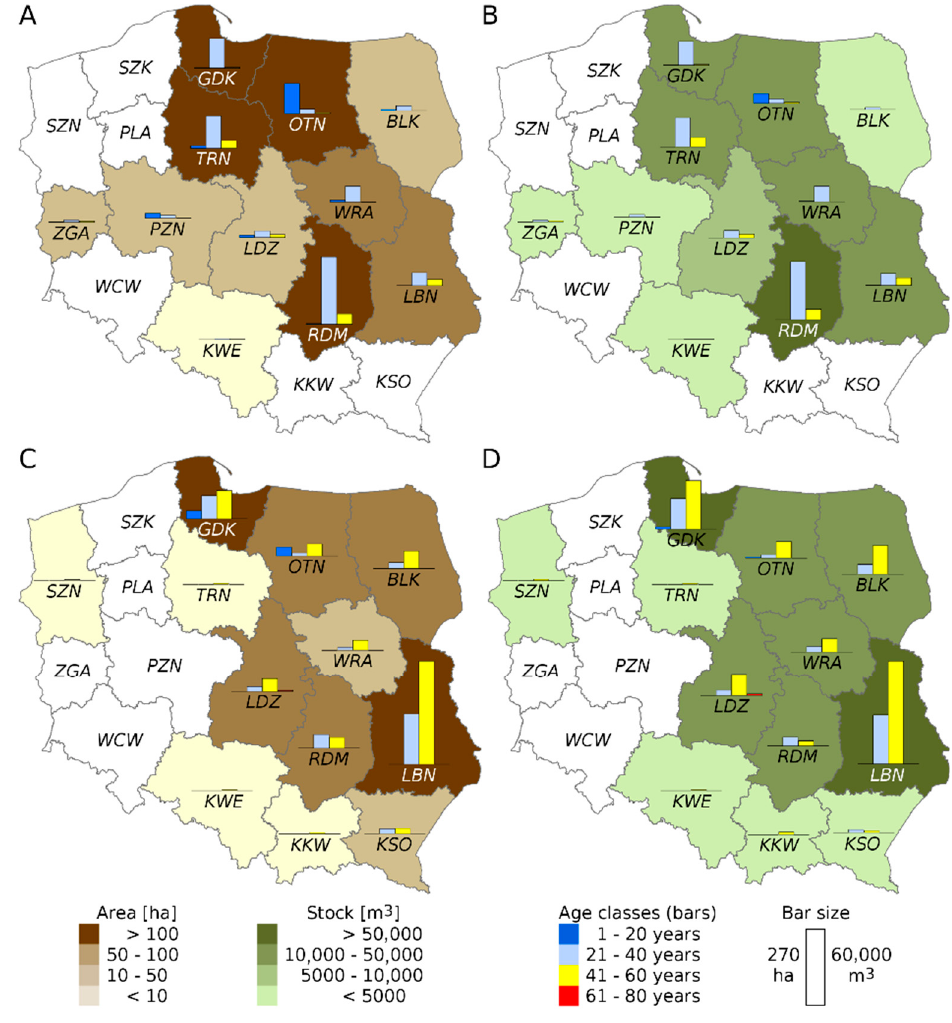
Figure 1. Arrangement of fast-growing tree plantations: ( A , B) larch and ( C , D ) poplar in the regional LP Directorates. The carto diagram of the surface and stock (thickness) broken down into age classes (bars) and the cartogram of the total surface (bronze shades, A , C ) and thicknesses (shades of green, B , D ). In the RDLP without the colours and bars, there is a lack of fast-growing tree plantations. The sizes of the bars are linear. The symbols of the regional names of the LPs are explained in Abbreviations. In addition to the legend: On the left, cartographic explanations (colours RDLP: shades of brown-surface and green-stock). On the right-hand side, explanations for the carto diagrams (the colours of the bars and their sizes). Abbreviations: RDLP-Regional Directorates of the State Forests; BLK-RDLP in Białystok; GDK-RDLP in Gda´nsk; KKW-RDLP in Krak ó w; KSO-RDLP in Krosno; KWE-RDLP in Katowice; LBN-RDLP in Lublin; LDZ-RDLP in Ł ó d´z; OTN-RDLP in Olsztyn; PLA-RDLP in Piła; PZN-RDLP in Pozna´n; RDM-RDLP in Radom; SZK-RDLP in Szczecinek; SZN-RDLP